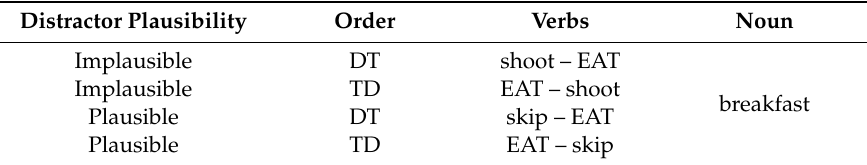
Table 1. Sample of experimental manipulation ( eat breakfast